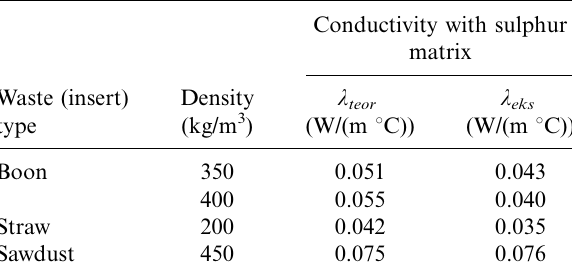
Table 5. Thermal conductivity of the composite material made of